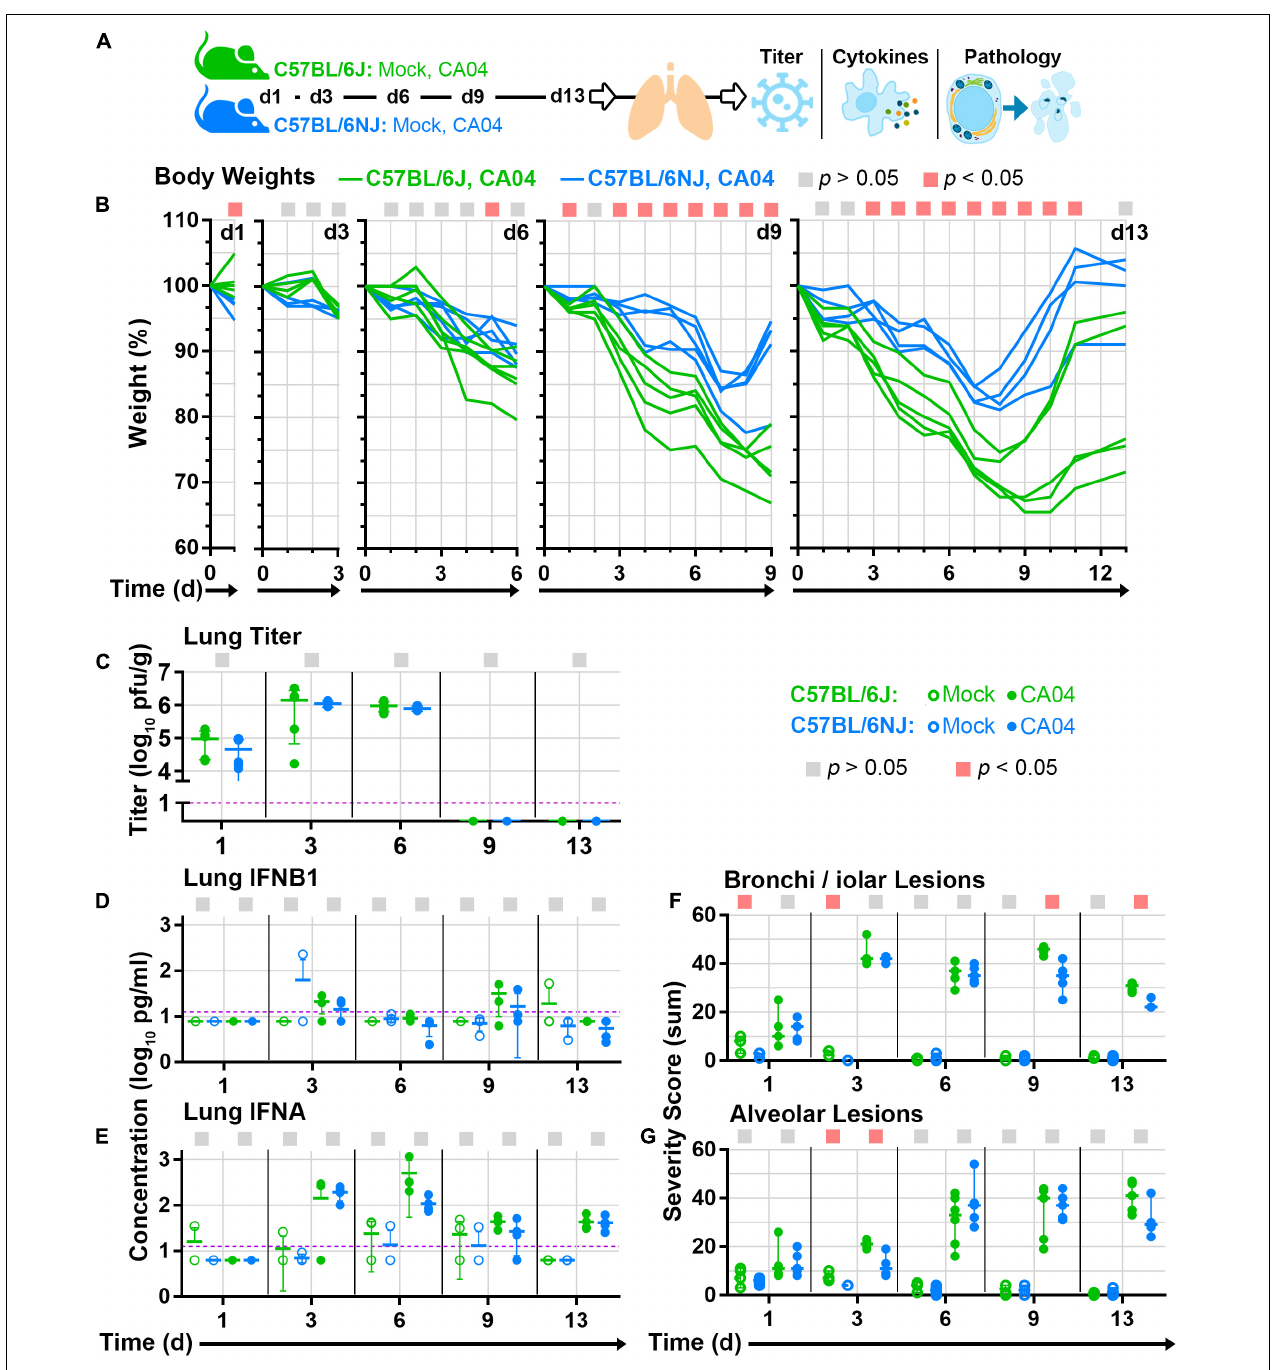
FIGURE 3 | Lung tissue analyses. Groups C57BL/6J or C57BL/6NJ mice were mock-infected (with PBS) or infected with a sub-lethal dosage (3.4 × 10 4 pfu) of CA04, euthanized at five time points [day 1 (d1), d3, d6, d9, and d13; four to six mice were euthanized per group at each time point], and lung tissues were collected and divided for various analyses. (A) Overview of mouse lung tissue collection time points and subsequent analyses. (B) Individual mouse body weight ratio profiles are shown for CA04-infected C57BL/6J and C57BL/6NJ mice in each time point group. (C) Individual lung titers are shown for each CA04-infected mouse at each time point. Concentrations of (D) IFNB1 or (E) IFNA in lung homogenates are shown for individual mock-infected and CA04-infected mice at each time point. Individual histopathology sum severity scores of (F) bronchi/iolar lesions and (G) alveolar lesions are shown for mock-infected and CA04-infected mice at each time point (see Supplementary Table S1 for all histopathology scoring data). In (A–G) , the colored squares at the top of each graph indicate statistically significant differences between C57BL/6J and C57BL/6NJ for a given comparison. In (C–E) , group means are shown by horizontal bars, error bars indicate standard deviation, and the limit of detection is represented by a dashed purple line. In (F,G) group medians are shown by horizontal bars and error bars indicate the 95% confidence interval. d, day; pg, picograms; g, gram; ml, milliliter.